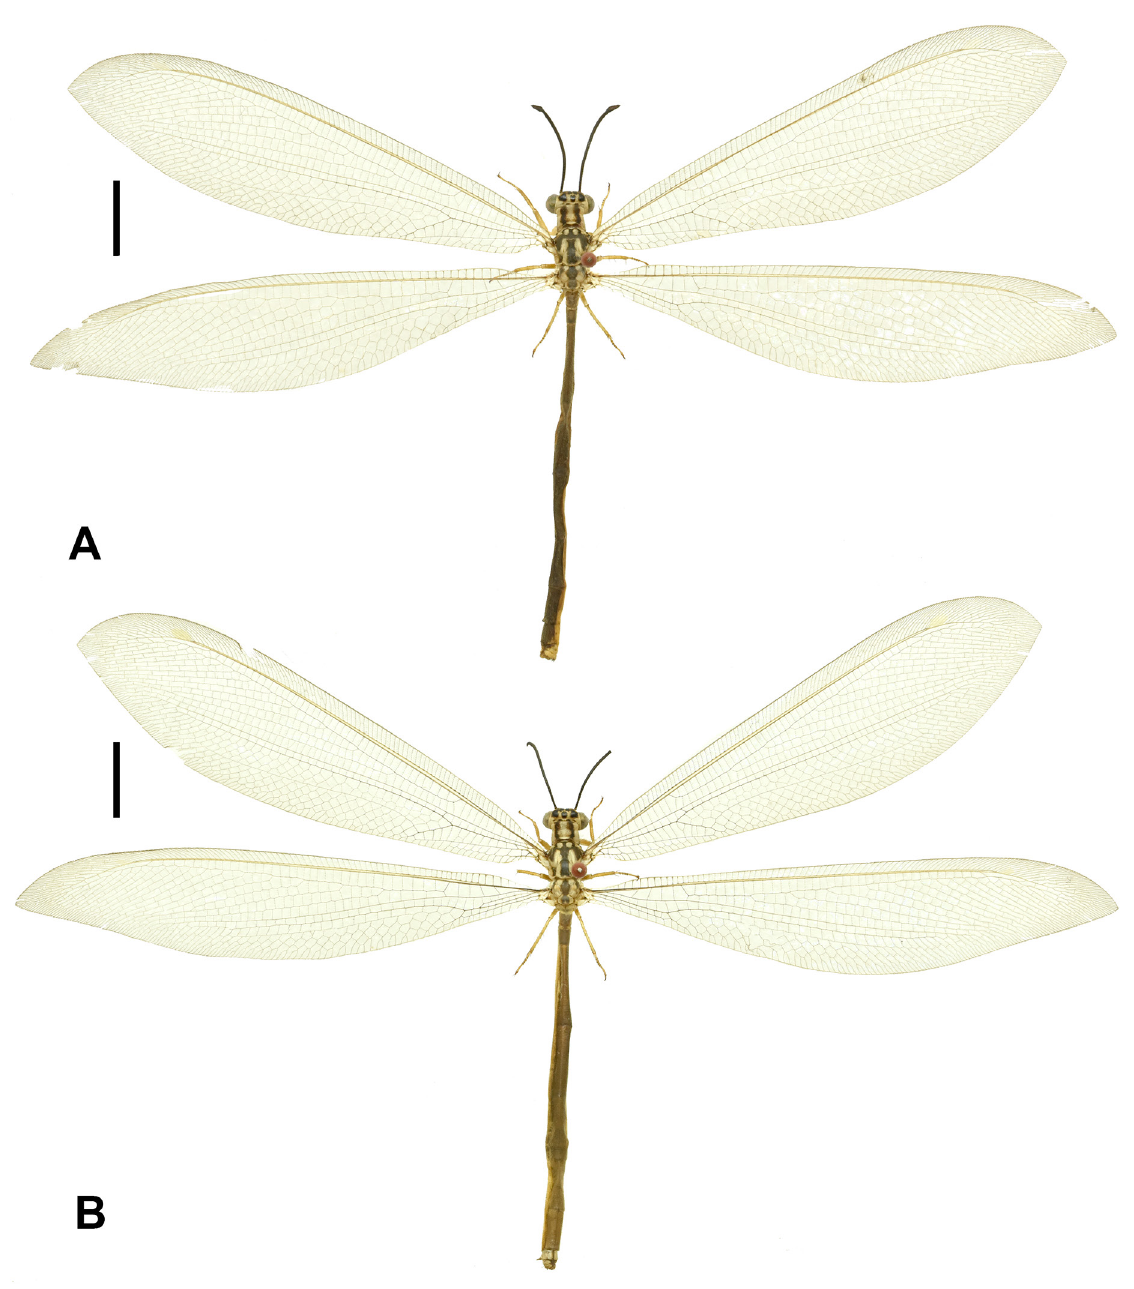
Fig. 1. Baliga kashmirensis sp. nov. Dorsal habitus. A . Male (CAUPK00001). B . Female (CAUPK00002). Scale bars = 5.0